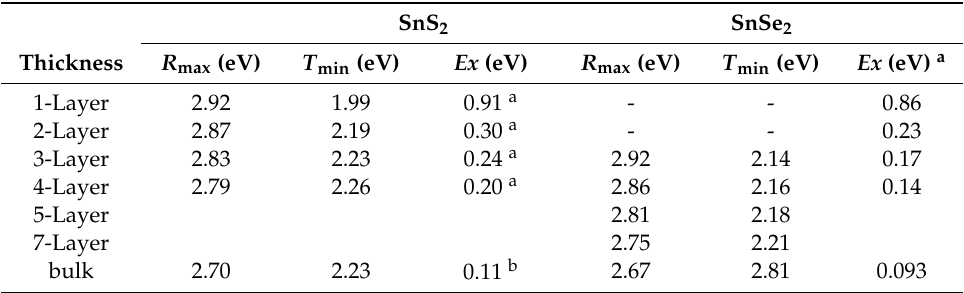
Table 1. Comparison of the reflectance contrast peak ( R max ), the transmittance minimum ( T min ), and the exciton binding energy ( Ex ) of SnS 2 and SnSe 2 of di ff erent thickness. ( a Theoretical exciton binding energy obtained by ab initio calculation [48]; b Measured exciton binding energy in